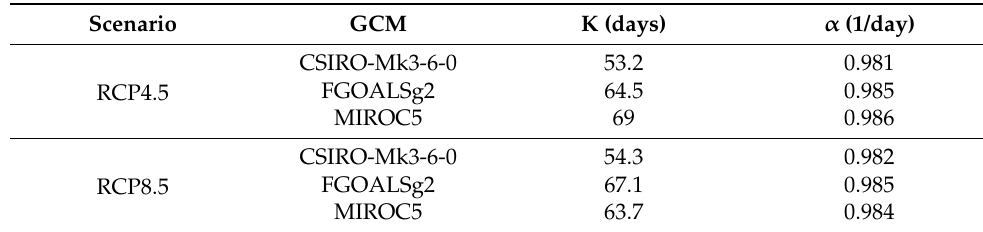
Table 3. Recession analysis derived from three general circulation models and two scenarios for future climate conditions (2010–2054).